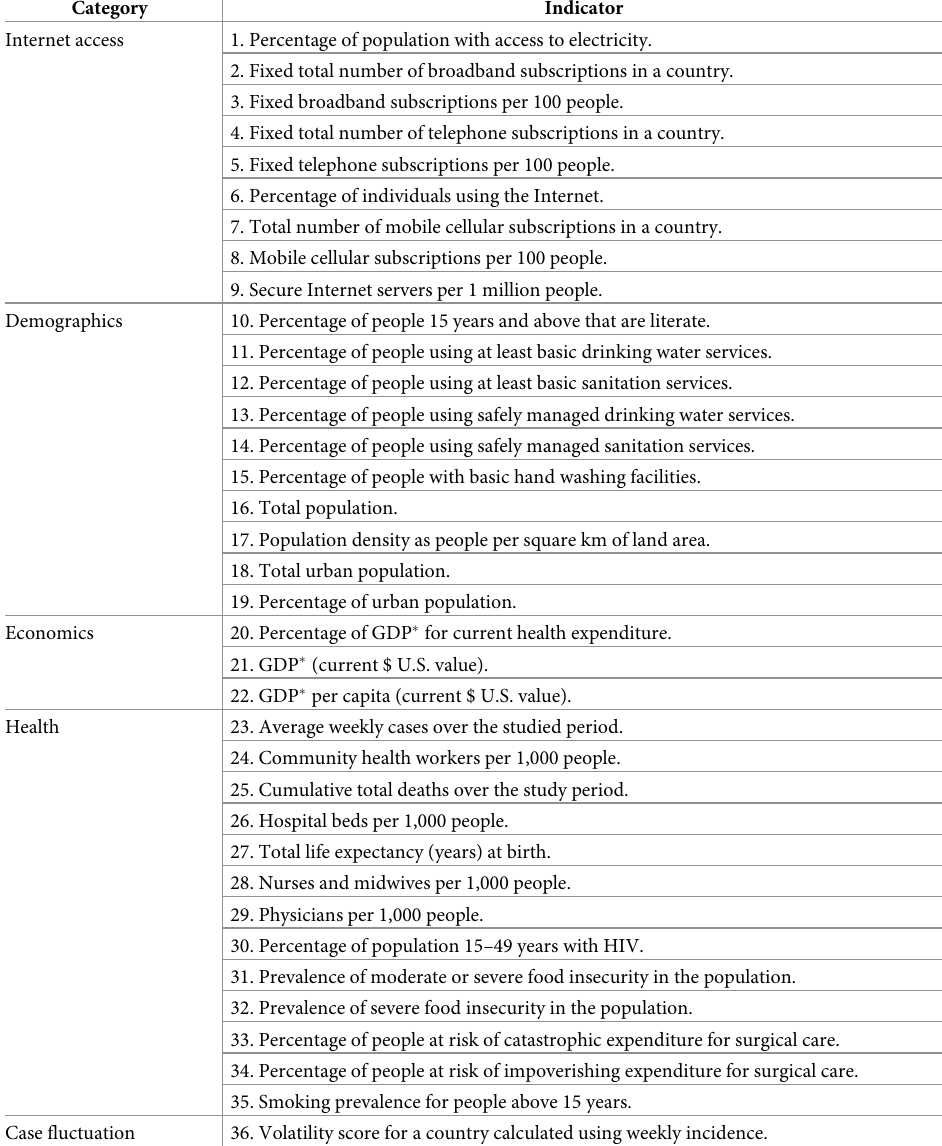
Table 1. Independent variables explored in the present study. Different categories were selected based on their per- ceived potential to explain patterns of Google Health Trends and COVID-19 regression models. We also evaluated the log of each variable, for a total of 72